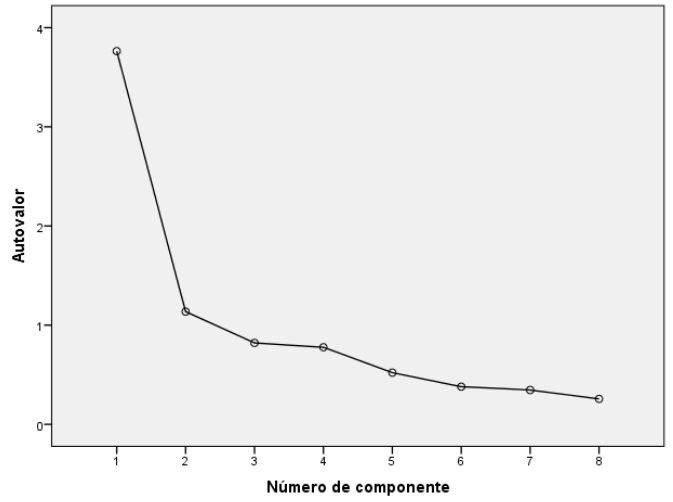
Figure 1. Scree Figure 1. Scree plot.